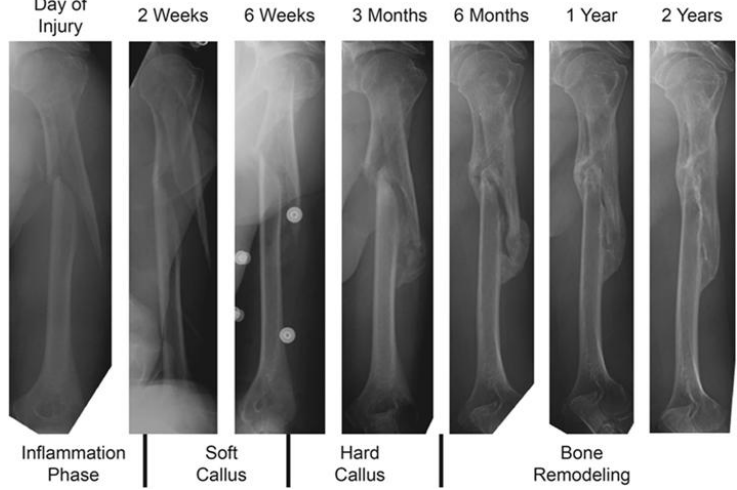
Figure 7. Representation of bone in bone healing. Reproduced with permission from ref. [80].